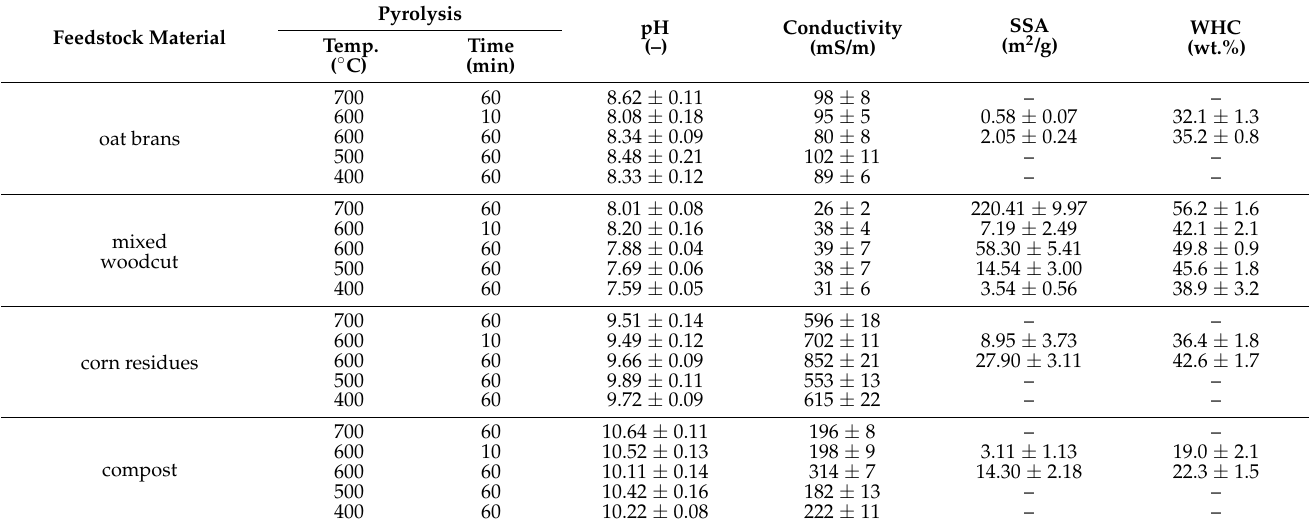
Table 2. pH and conductivity of aqueous extracts, specific surface area (SSA) and water holding capacity (WHC) of biochar samples produced from the individual biomass feedstocks at various pyrolysis conditions (temperature, residence